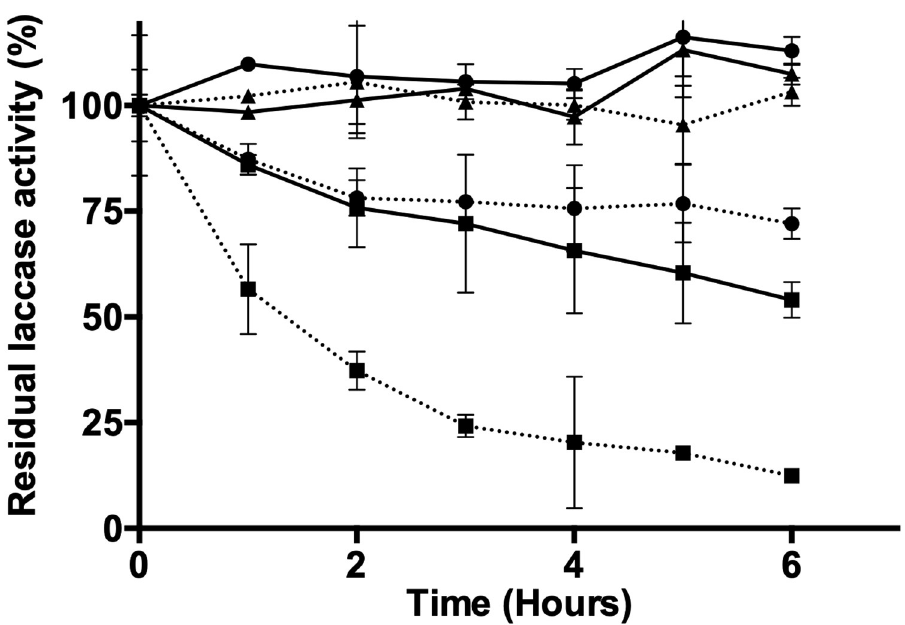
Fig 4. Thermal stability of a D . pusillus LMB4 extract exhibiting laccase activity. Laccase activity was measured after different temperature incubations: 40˚C (triangles), 50˚C (circles), and 60˚C (squares). Solid lines represent the crude fungal enzymatic extract from D . pusillus LMB4, while dashed lines represent the commercial laccase from T . versicolor , 53739. Average values and standard deviation were obtained from three replicates of each point.